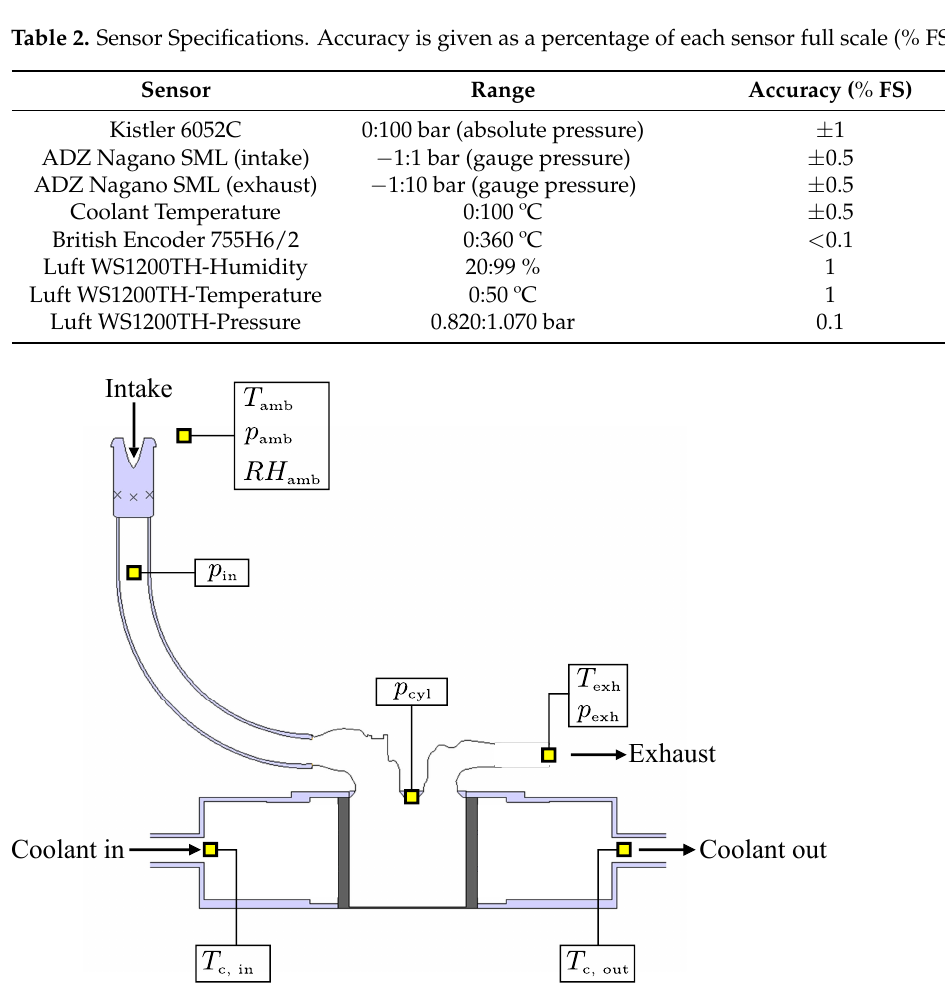
Figure 3. Sensors layout for the engine gas path and coolant system. The in-cylinder pressure ( p cyl ) is measured with a Kistler 6052C piezoelectric trans- ducer, installed on the cylinder head. The sensor signal is conditioned by a Kistler